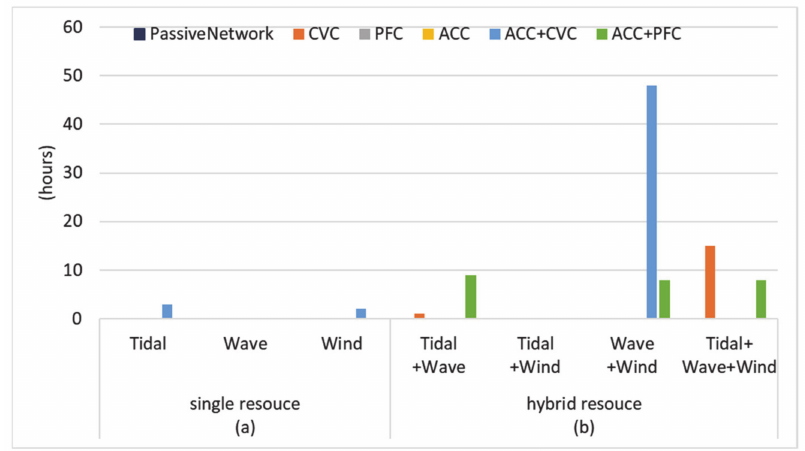
Figure 7. Total hours in the year when at least one bus voltage reaches its lower limits: ( a ) for single resource networks and ( b ) for hybrid resource networks.